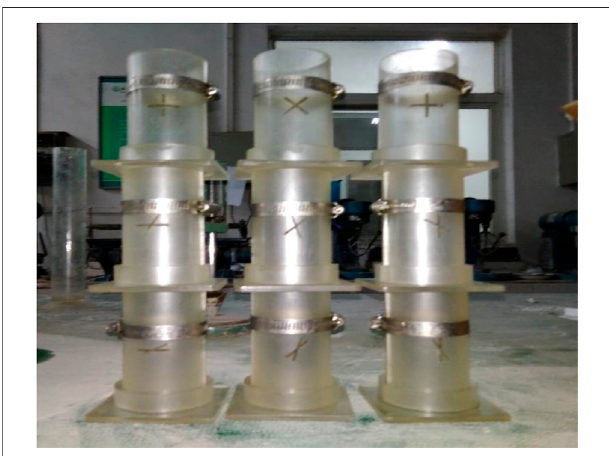
FIGURE 2 | Molds used in the